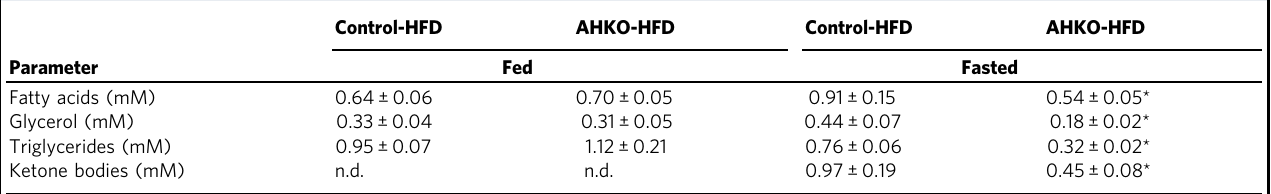
Table 1 Plasma parameters of control and AHKO mice fed HFD.